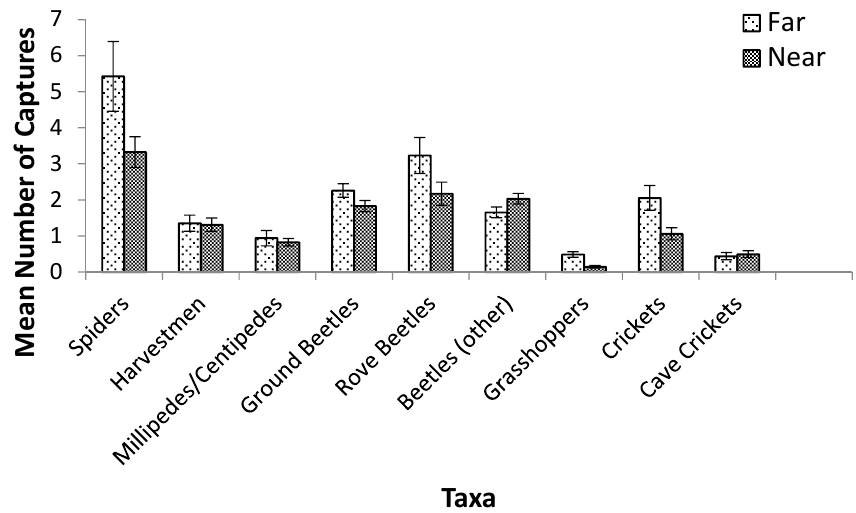
Figure 2. Mean (+SE) number of invertebrate captures near and far from piled woody debris in 10 harvested sites in western North Carolina (2016–2017).